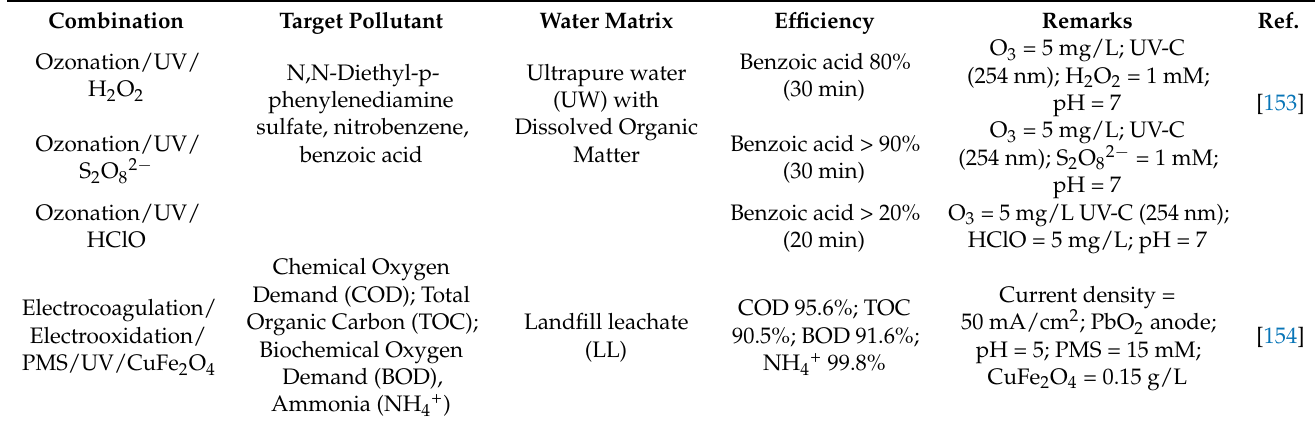
Table 12. Sequential or two-step combination of advanced oxidation